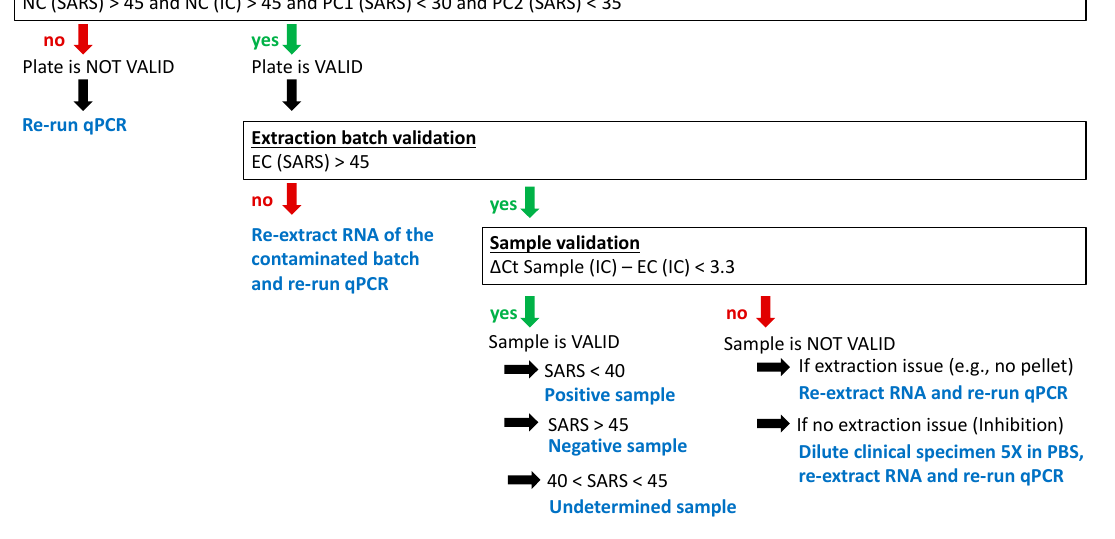
Figure 5. Validation process of the RT-qPCR data.